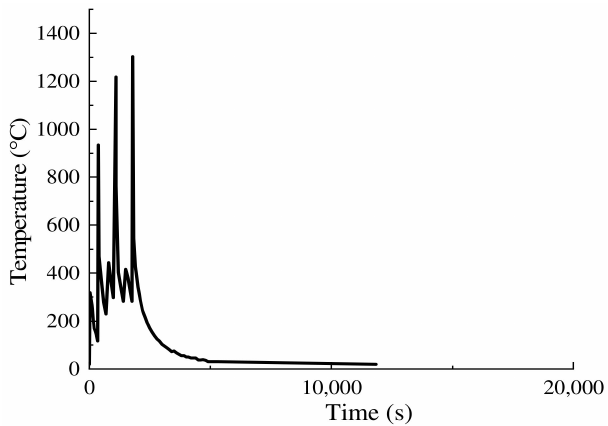
Figure 6. Temperature change curve at Point A in Model